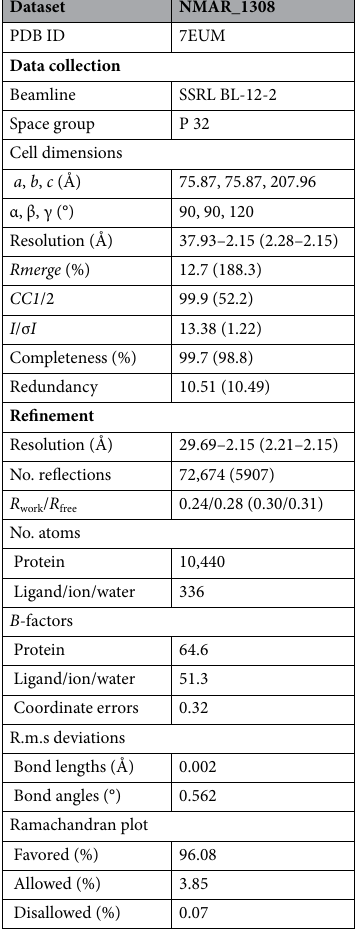
Table 1. Data collection and refinement statistics of X-ray crystallography data collection and structure refinement. Numbers corresponding to the highest resolution shell are shown in